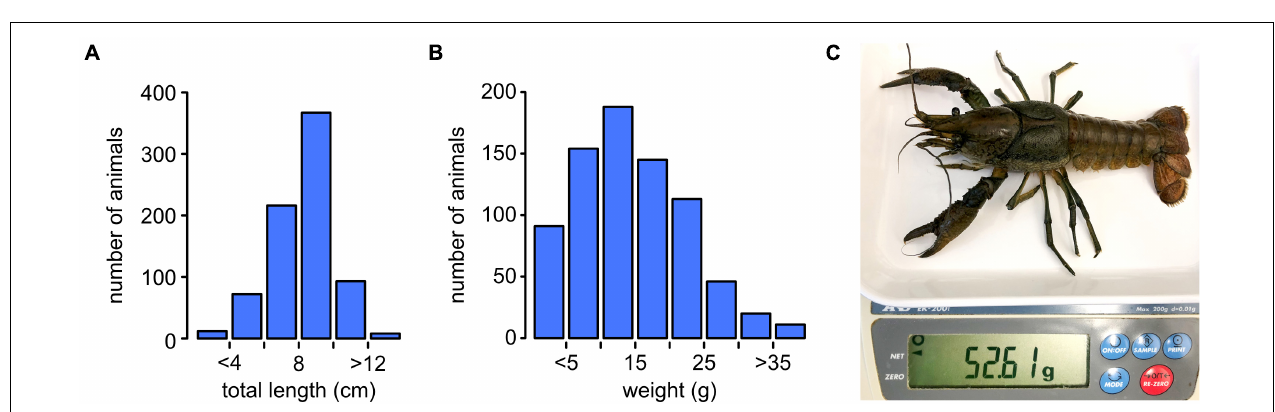
FIGURE 1 | (A) Murner See, a German lake with a stable marbled crayfish population. The lake floods a former coal mining area. (B) Chemical water parameters of Murner See (blue bars). Comparative values are indicated for Krumme Lanke (yellow bars), another representative marbled crayfish habitat (Maiakovska et al., 2021). (C) Underwater photograph from Murner See, with a marbled crayfish specimen in front of a burrow.